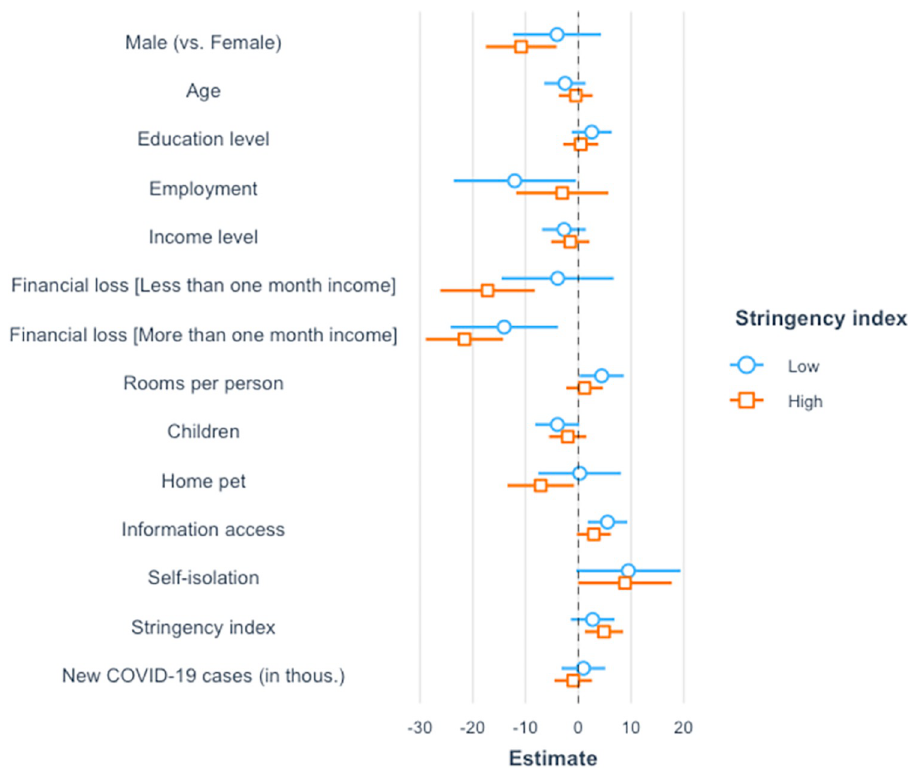
Fig 7. Standardized regression coefficients for support of restrictive measures in groups with different level of stringency index. Standardized regression coefficients with 95% CIs are shown. The confidence interval of the effect estimate should not overlap with zero for the effect to be considered statistically